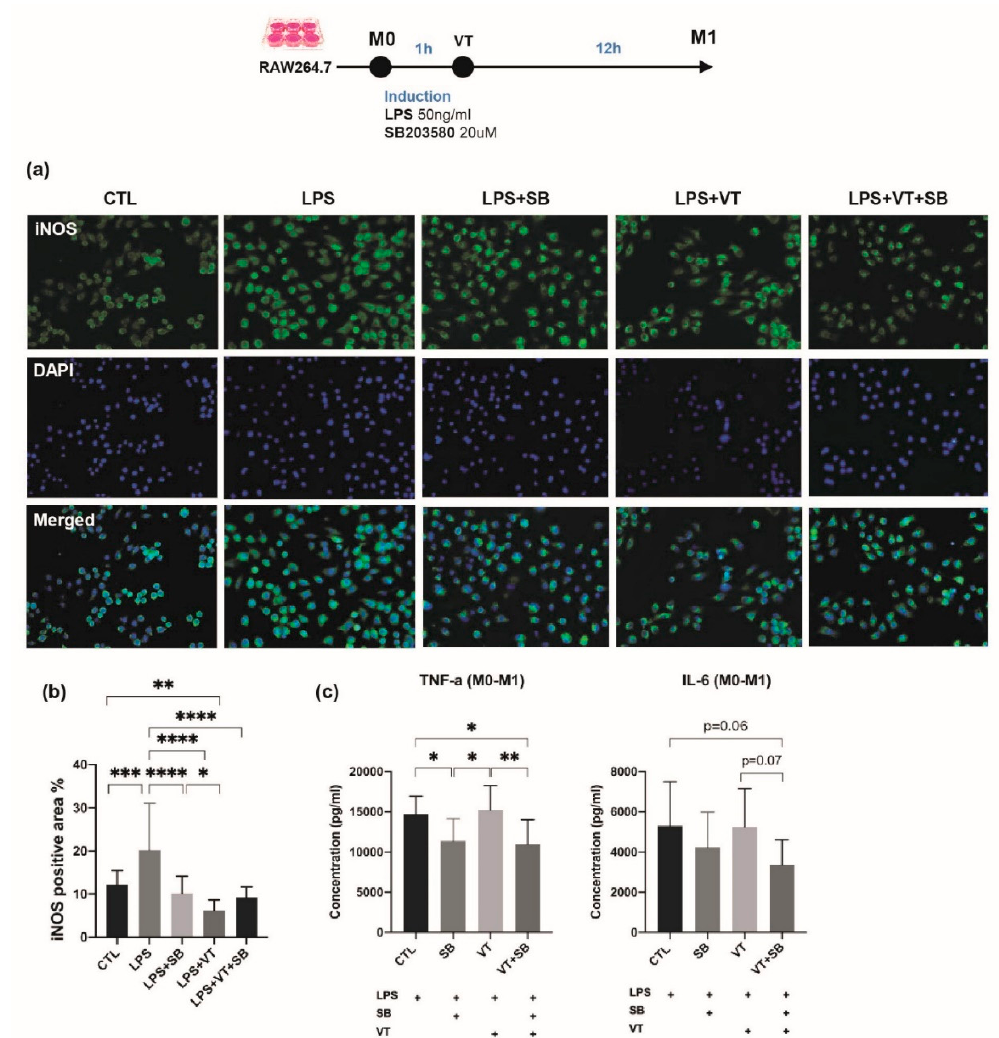
Figure 6. Immunofluorescent staining and inflammatory cytokine levels among different treatment groups for induction of M1 macrophage. ( a ) Immunofluorescence staining of in vitro cultured RAW 264.7 macrophages labeled with the M1 marker of inducible nitric oxide synthase (iNOS) and nuclear counterstaining with DAPI. LPS treatment showed strong intracytoplasmic labeling of M1 for iNOS. LPS-treated M1 macrophages were characterized by an enlarged amoeboid cell shape with roundish cell bodies and numerous delicate cytoplasmic extensions on the cellular surface. The LPS+SB group, LPS+VT group, and LPS+VT+SB group showed larger cell sizes, more multinucleid-fused cells, yet fewer cell numbers. ( b ) LPS treatment significantly increased the iNOS positive area percentage compared with the CTL group, while the SB group, VT group, and SB+VT group significantly decreased the iNOS positive area percentage compared with the LPS group. The percentage of the iNOS positive area of the VT group was also significantly lower than the CTL group and SB group. ( c ) The SB group showed significantly lower TNF- α concentrations compared with both the CTL group and VT group, while the VT+SB group showed significantly lower TNF- α concentrations compared with both the CTL group and VT group and lower trend of IL-6 concentration than the CTL group and VT group ( n = 10). * p < 0.05, ** p < 0.01, *** p < 0.001, and **** p < 0.0001. Scale bars = 50 μ m.